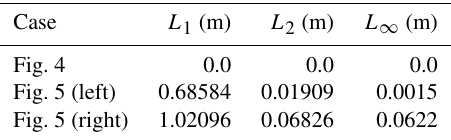
Table 2. Analytical steady flows: summary of L norms for errors in water depth; L norms for errors in unit discharge are in the range of machine accuracy and omitted